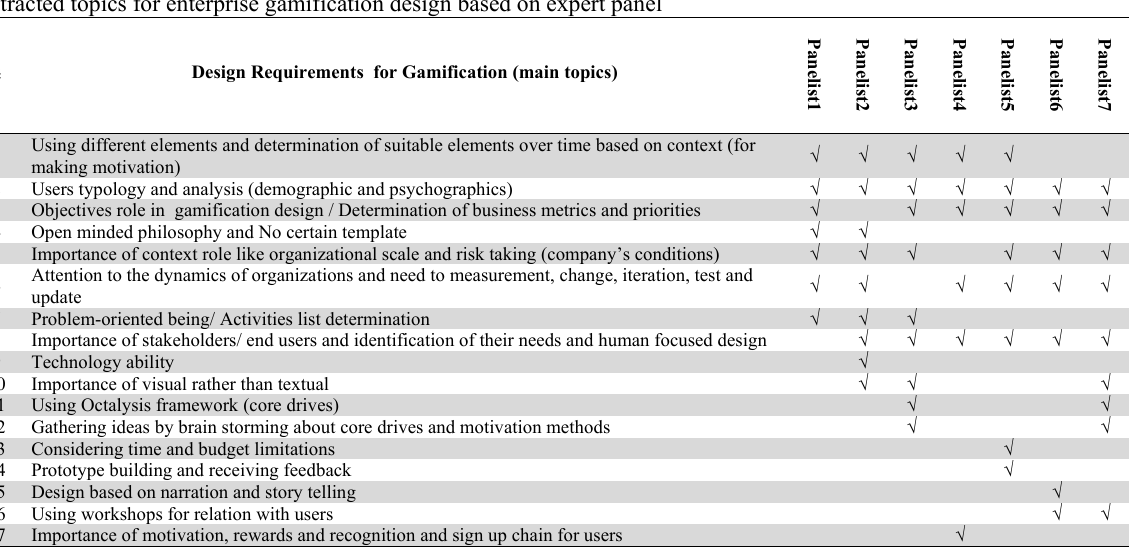
Extracted topics for enterprise gamification design based on expert